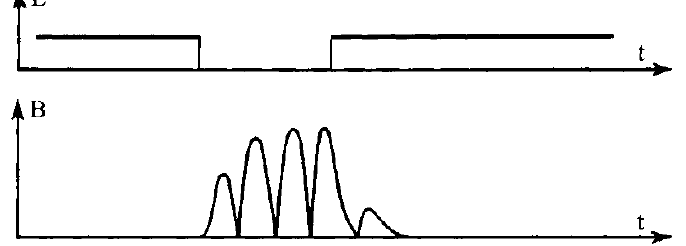
FIGURE 6 The time dependence of the output signal B ( t ) and the input signal L ( t ) for the NOT